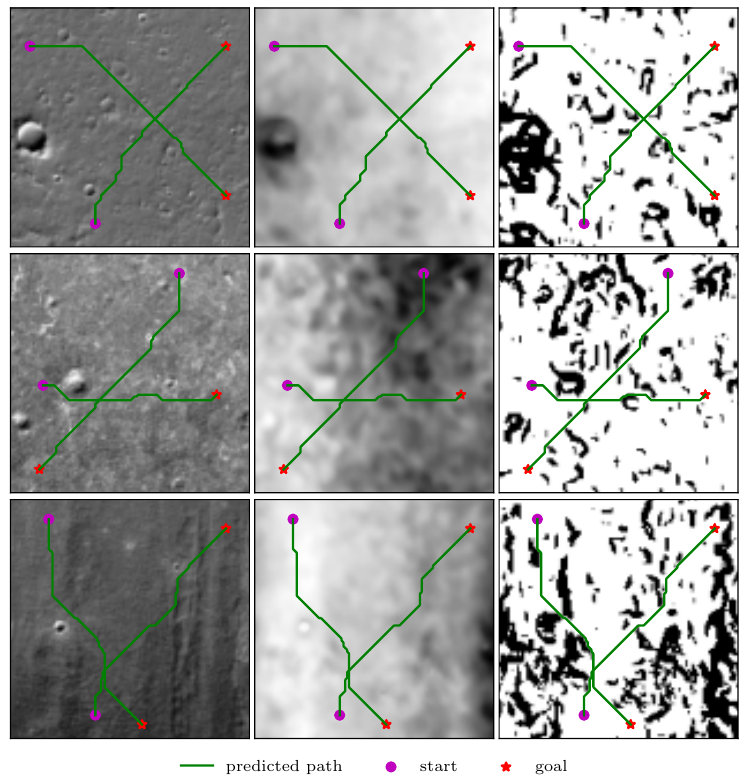
Figure 7. The predicted trajectories between random start and target positions in the lunar domains. From left to right: terrain image, DEM, and grid map, generated from DEM with the resolutions of 128 128. Note that the terrain image is used as the network input, and the elevation data is not × available for the learning